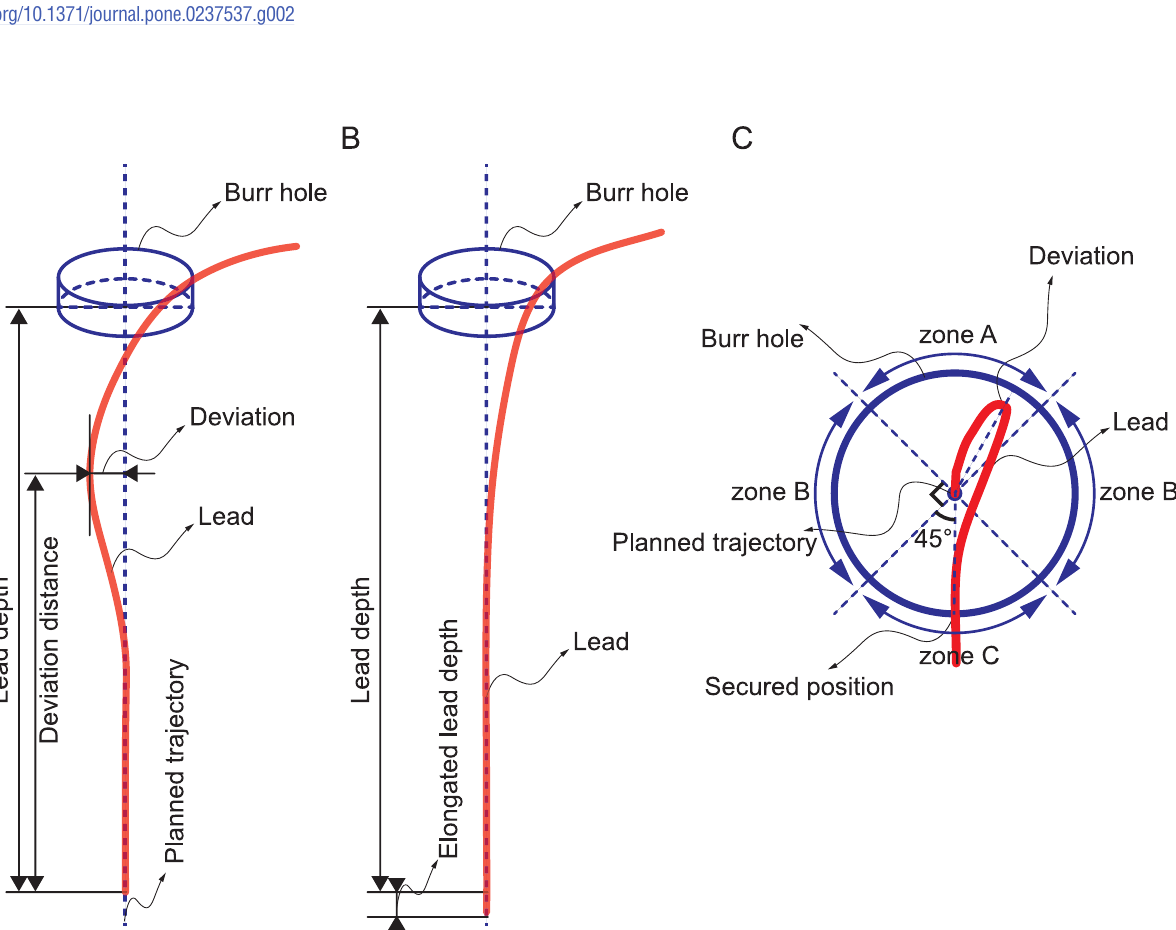
PLOS ONE | https://doi.org/10.1371/journal.pone.0237537 August 12,